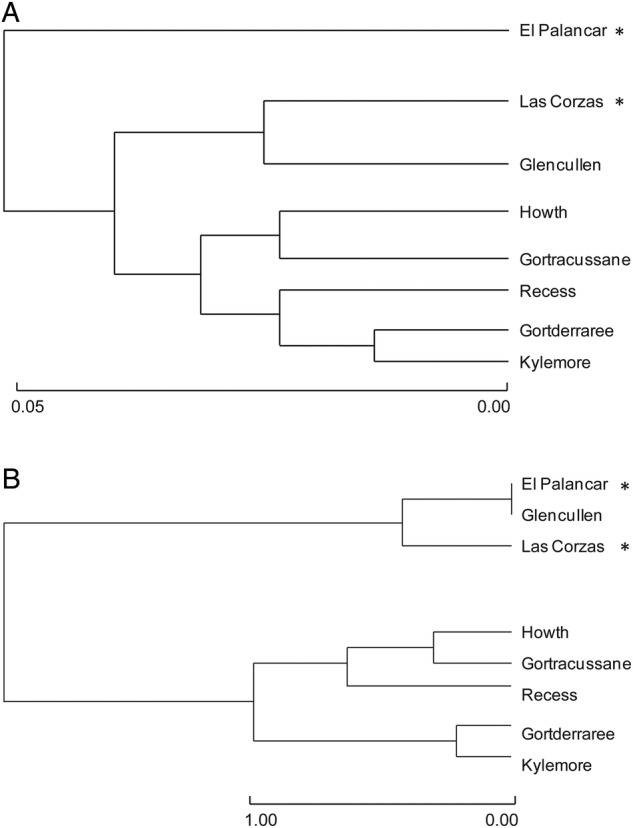
Rooted UPGMA tree depicting relationships between the populations investigated based on: (A) the AFLP data set and (B) the SSR data set using Nei's genetic distance (Nei 1972). Asterisks indicate native Spanish populations and scale bars represent genetic distance.